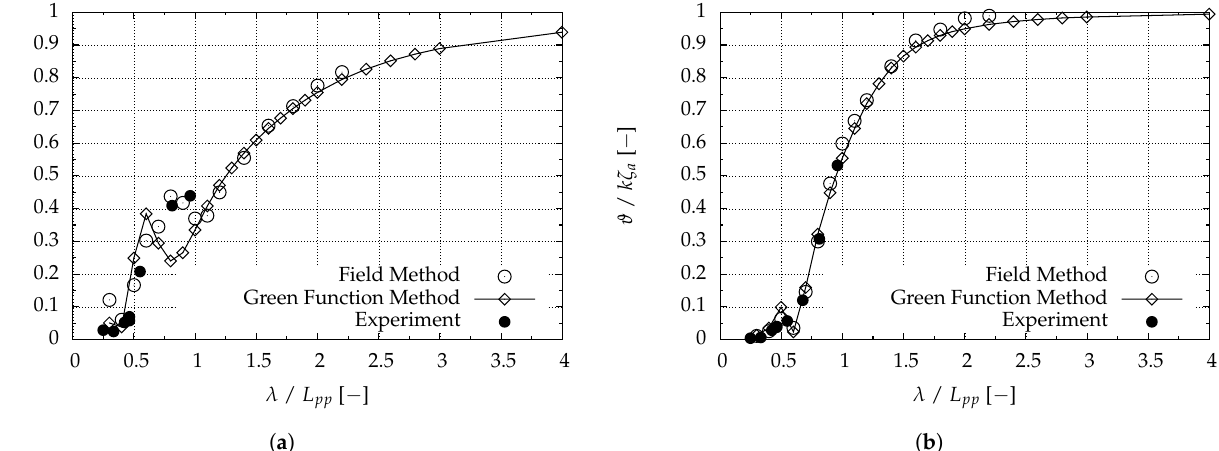
Figure 5. Containership: computed and measured RAOs: ( a ) heave motion ζ and ( b ) pitch motion ϑ . ζ a is the wave amplitude, k the wave number.